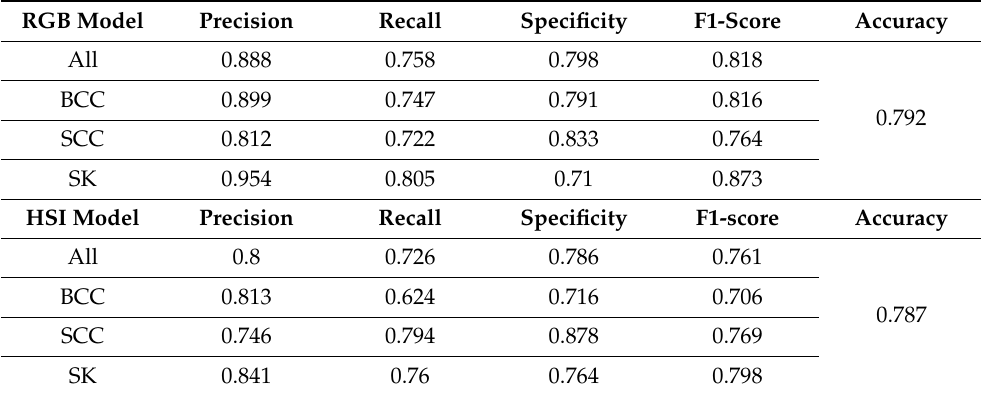
Table 2. Performance results of YOLOv5